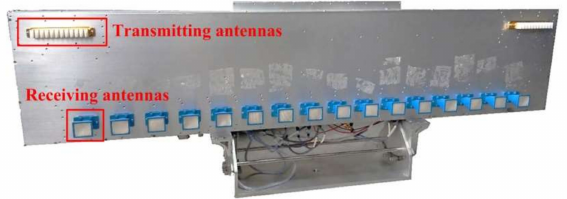
Figure 2. Photo of the ground-based multiple-input multiple-output (GB-MIMO) radar